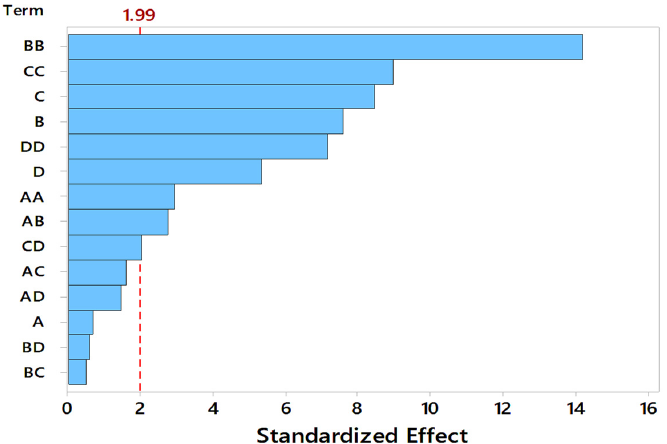
Figure 3. Pareto chart indicating the significance of process variables, A: Substrate Particle Size (mm), B: Initial pH, C: Moisture Content (%), D: Incubation Temperature ( ◦ C).